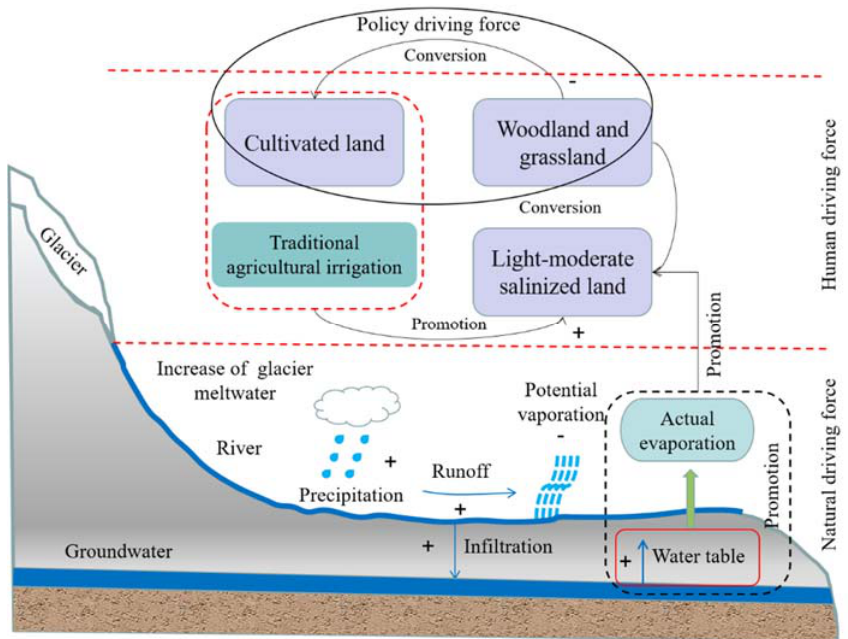
Figure 8. Schematic diagram of causes leading to the expansion of light ‐ moderate salinized land and the shrinkage of woodland and grassland in plain area of Aketao County, China. Note: + , − represent the increase and decrease, respectively.